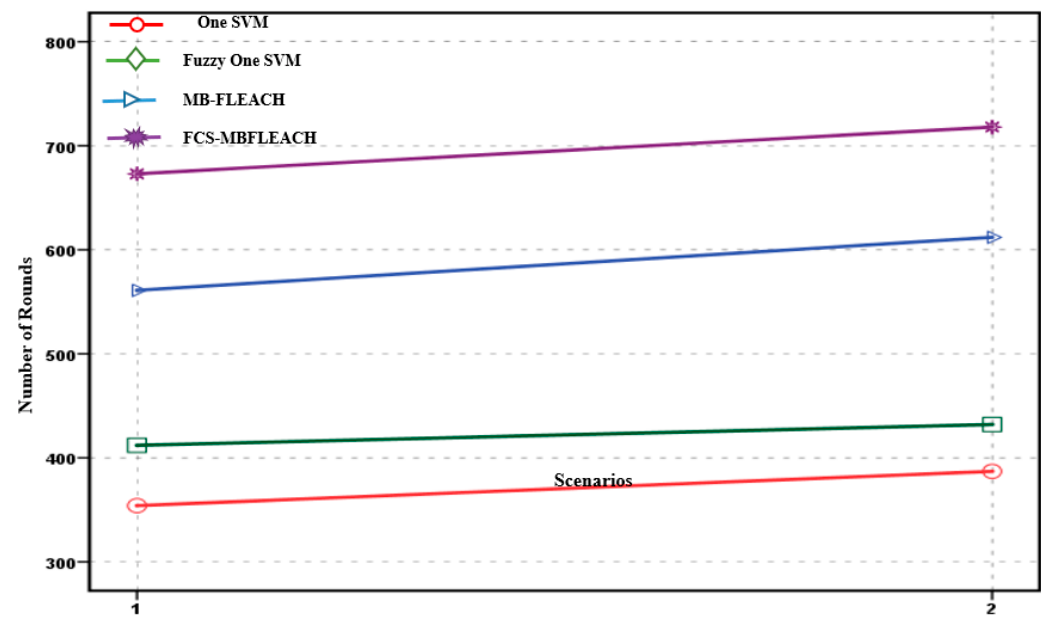
Figure 17. First node death (FND) for all methods in two scenarios.